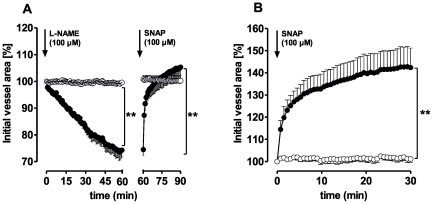
Responses of pulmonary arteries (PAs) and pulmonary veins (PVs) to L-NAME and SNAP.
A) (•) PV (n = 3); (○) PA (n = 3). B) (•) PV (n = 3); (○) PA (n = 3). Statistics was conducted using a linear mixed model analysis. P-values were adjusted for multiple comparisons by the false discovery rate. P<0.05 are considered as statistical significant and indicated as followed  p<0.05,  p<0.01 and  p<0.001.